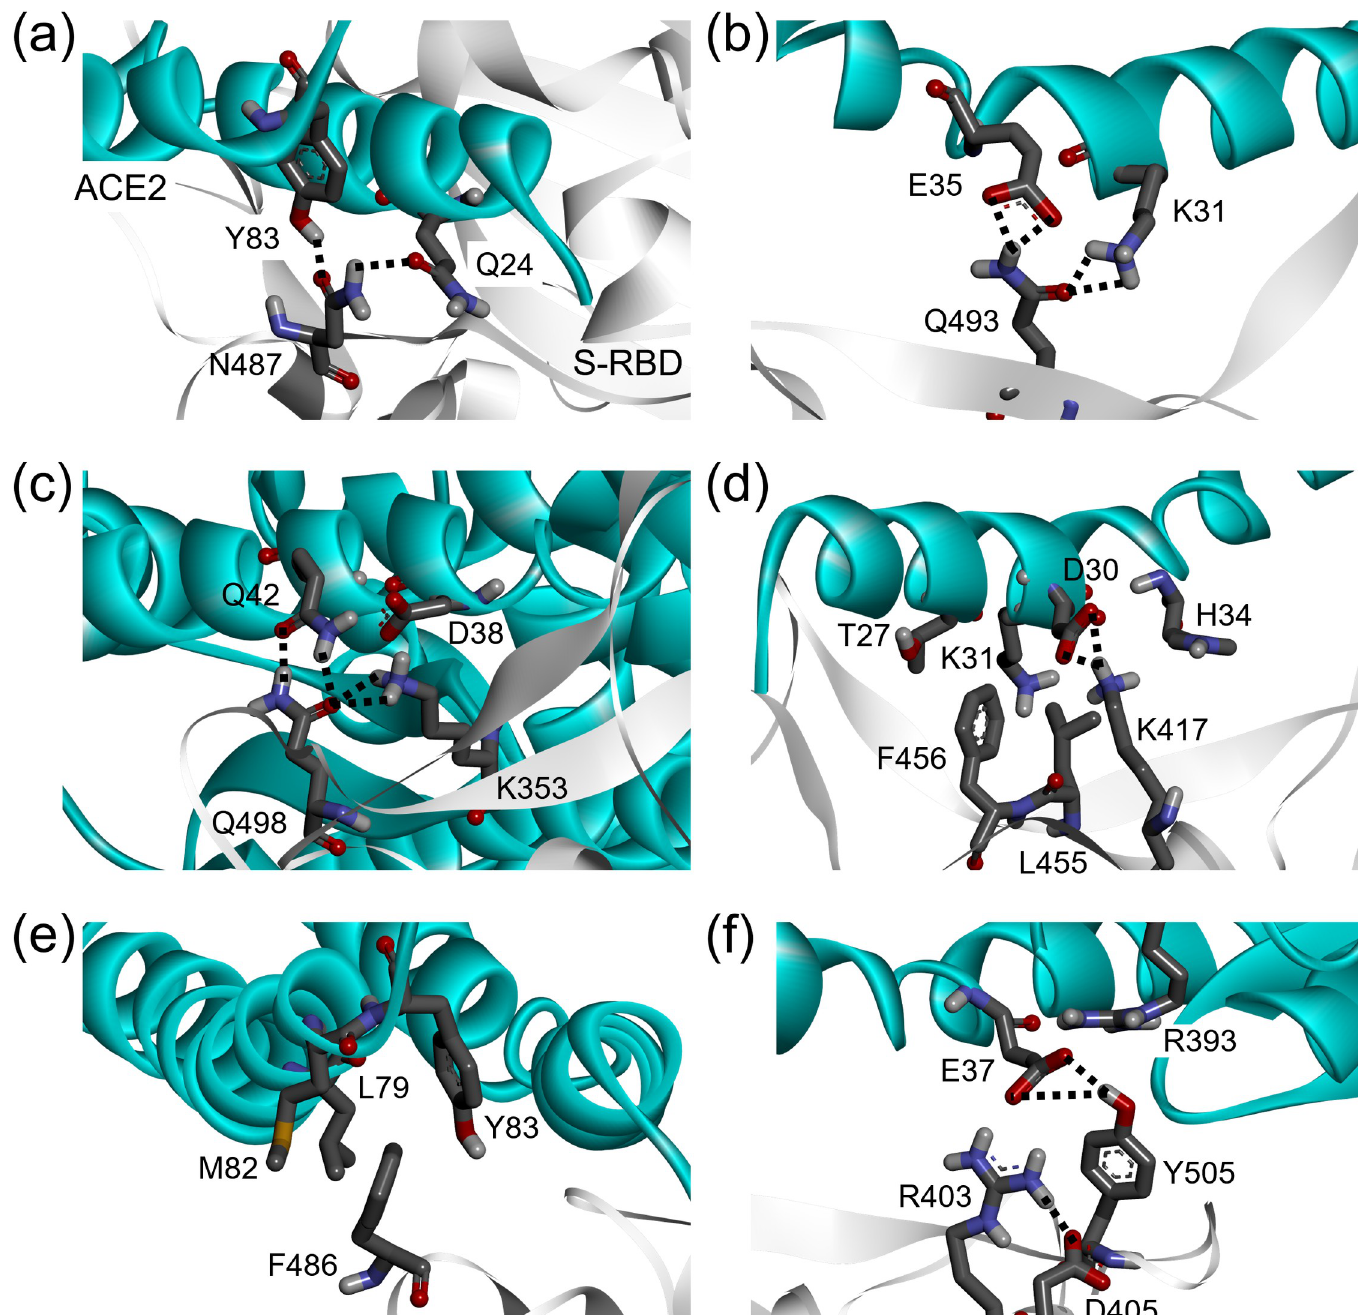
Fig 3. Structural details of the protein-protein interaction involving the S-RBD and ACE2 residues at the binding interface obtained from the Prod phase MD simulations. The secondary structures of S-RBD and ACE2 are portrayed as white ribbons and light-blue ribbons, respectively. Each interacting amino acid residue is highlighted in black-color labeled. The hydrogen bonds and salt bridges are represented in black and red dashed line,